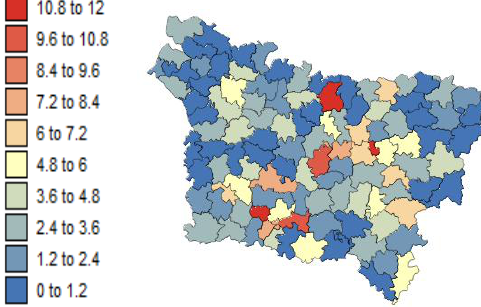
Figure 4. Maps of the pleural cancer mortality risk estimates and the corresponding prediction variances computed by Poisson kriging at three spatial scales: ( a ) county level; ( b ) grid level; and ( c ) IRIS